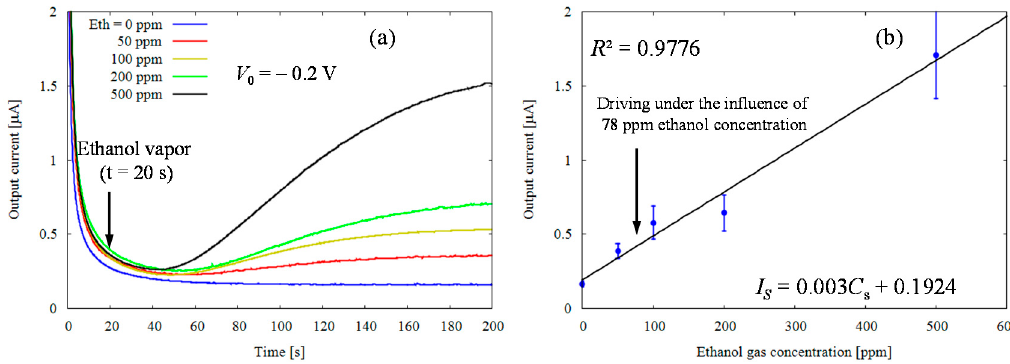
Figure 3. Typical current responses of modified chromatography paper enzyme electrodes for several ethanol gaseous concentrations. ( a ) The chronoamperometory at V 0 = − 0.2 V with 0, 50, 100, 200 and 500 ppm; ( b ) The calibration curve of the reduction current taken at t = 200 s by enzymatic catalyst on the concentration of ethanol gas.